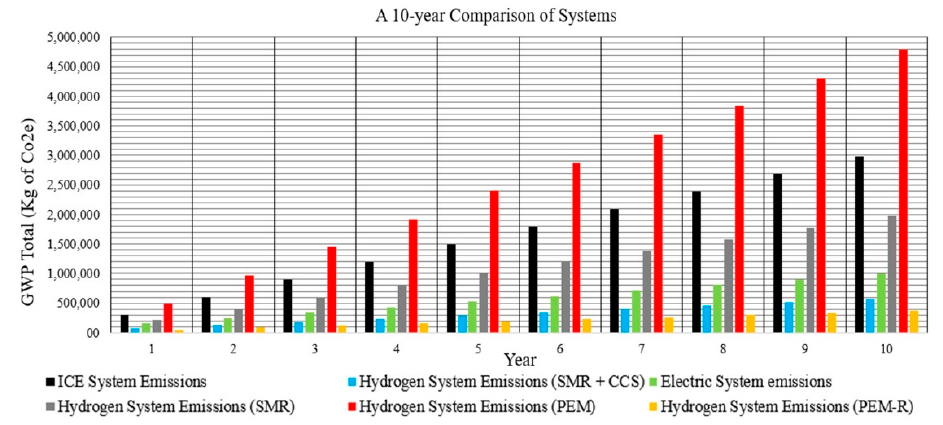
Figure 9. Power Unit Life Cycle GWPs over 10 years.